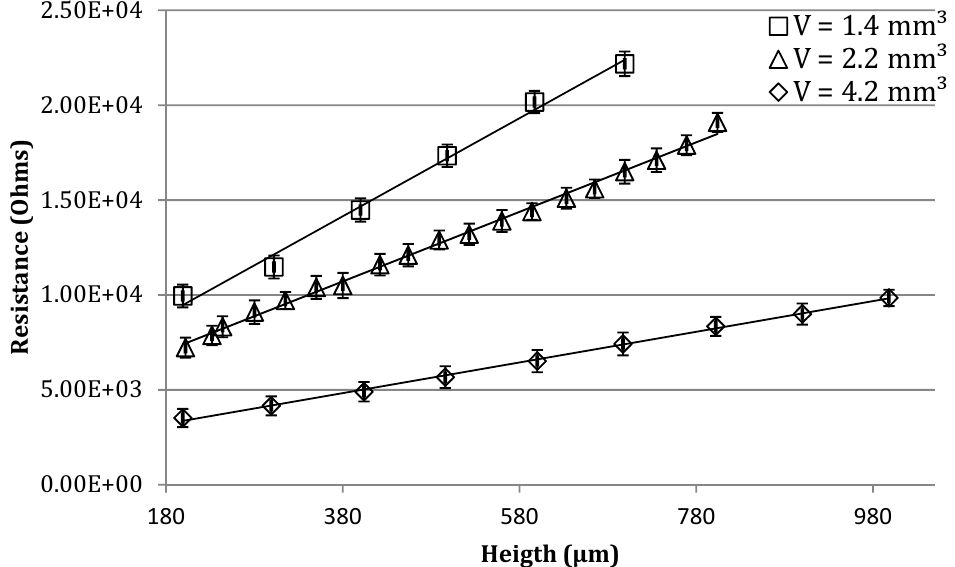
Figure 8. Droplet resistance as a function of its height for increasing volumes. The linear behavior with direction coefficient directed by volume is coherent with the simulations. The average curve showed a standard deviation of 606.9 Ohms, 551.1 Ohms, and 527.1 Ohms,